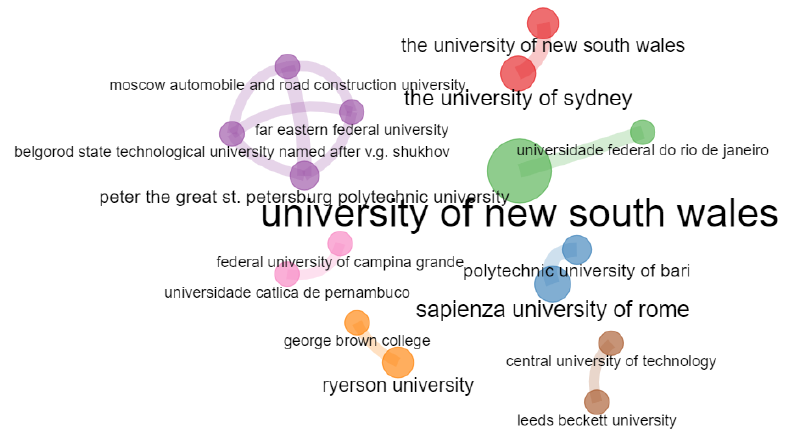
Figure 11. Collaboration network of institutions.